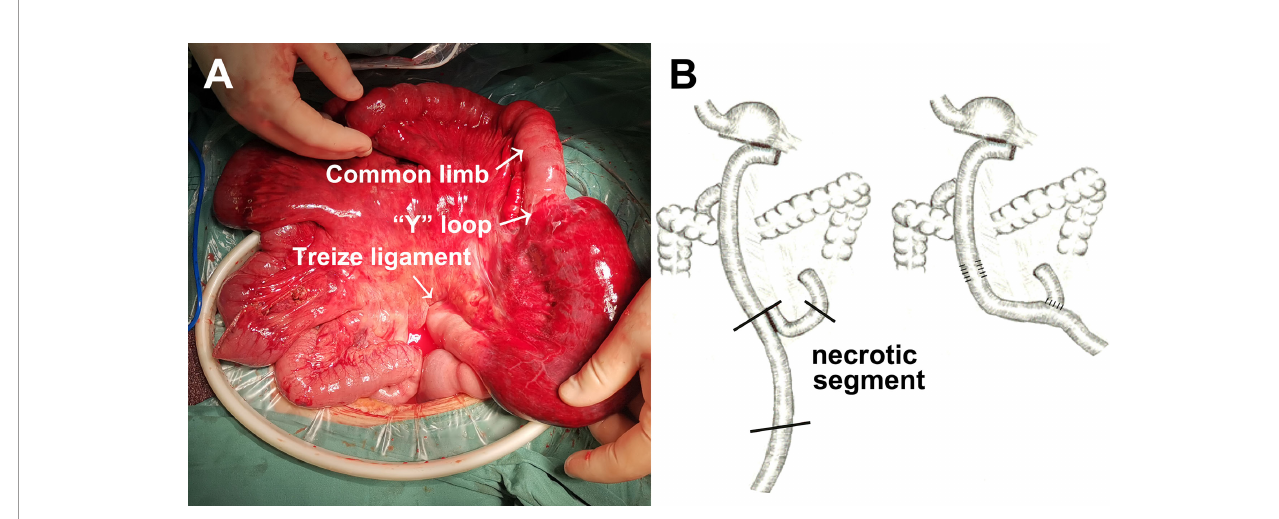
FIGURE 1 | An example of Petersen ’ s hernia concomitant with small bowel necrosis after gastrectomy. (A) Intraoperative detection of small bowel necrosis caused by Petersen ’ s hernia. (B) Graphic illustration of necrotic segment caused by Petersen ’ s